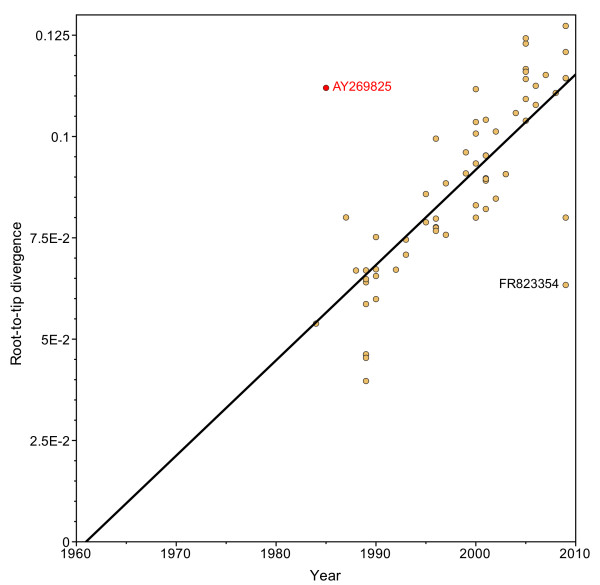
Regression plot for the complete RHDV VP60 dataset. Using the best-fitting root, the regression line indicates the relationship between the root-to-tip genetic distance and the isolation date of each taxon. The two outliers (AY269825 and FR823354, with residual values of 0.055 and 0.049, respectively) are indicated by GenBank accession number.